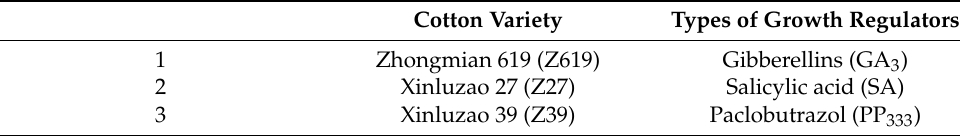
Table 1. Cotton varieties and growth regulators.